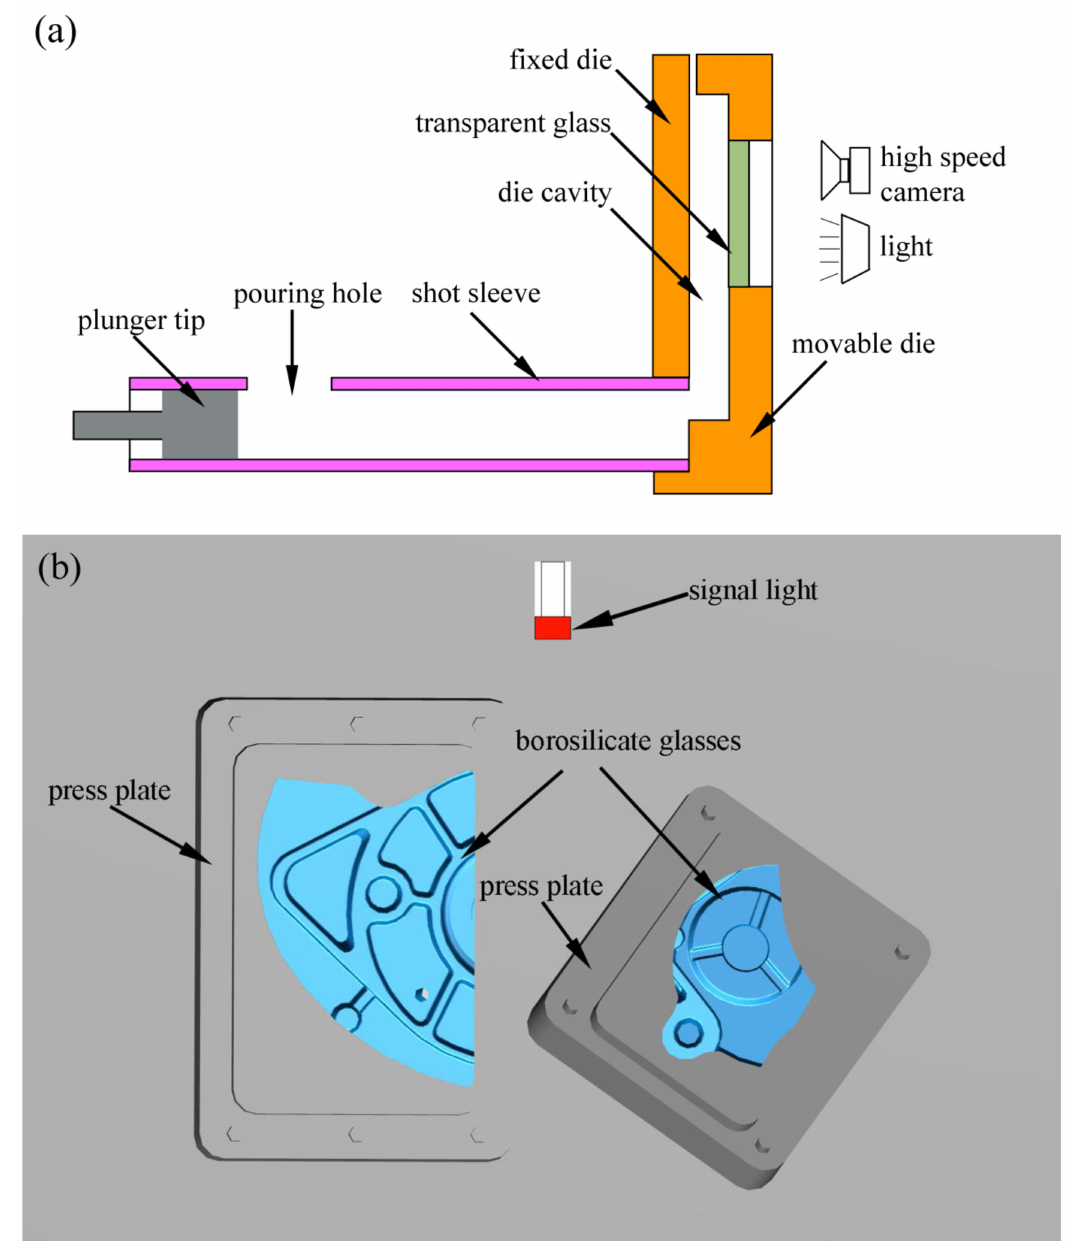
Figure 2. The flow visualization setup. ( a ) A schematic showing the flow visualization experiment setup; ( b ) the two shooting windows of high speed camera (the dimension of the bigger is 150 × 101 mm and the dimension of the smaller is 104 × 79 mm) on the movable